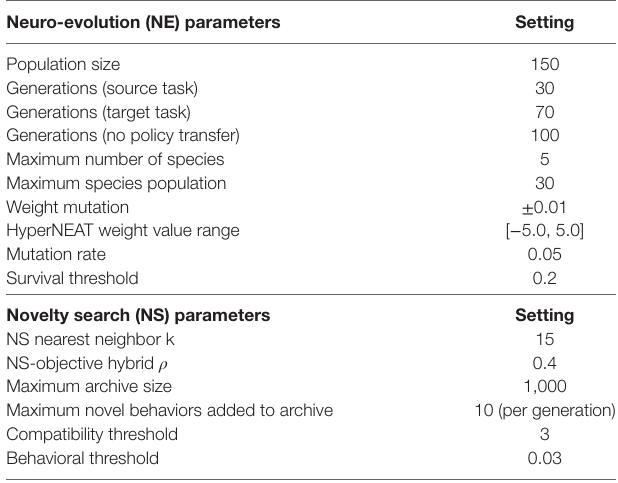
the best results. All other novelty search parameters are the same as used for NS variant (Section